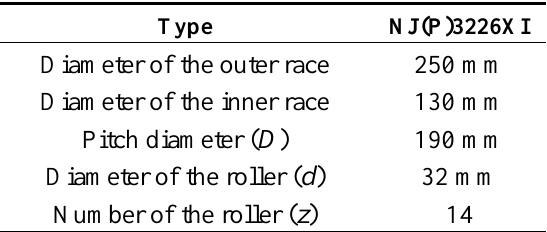
Table 3. Specifications of the testing